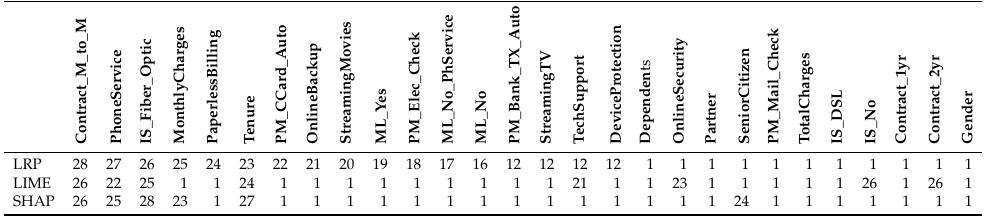
Table 5. Ranked feature comparison for LRP, SHAP, and LIME over the Telecom Churn dataset.